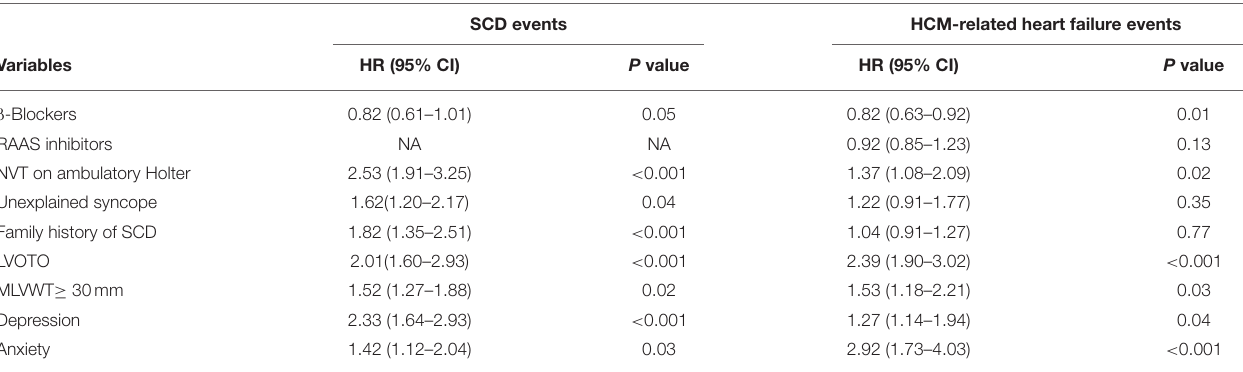
TABLE 4 | Multivariable Cox regression of variables influencing SCD events and HCM-related heart failure events.